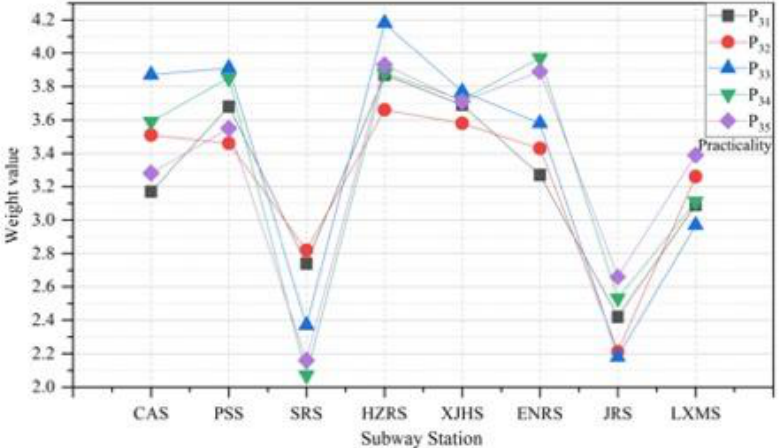
Figure 12. Environment practicality evaluation index results of sample station transfer spaces.